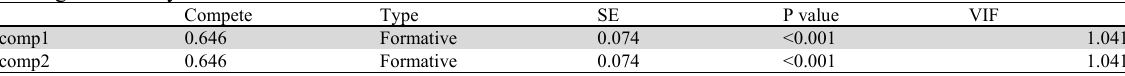
Convergent Validity of Formative Latent Variables